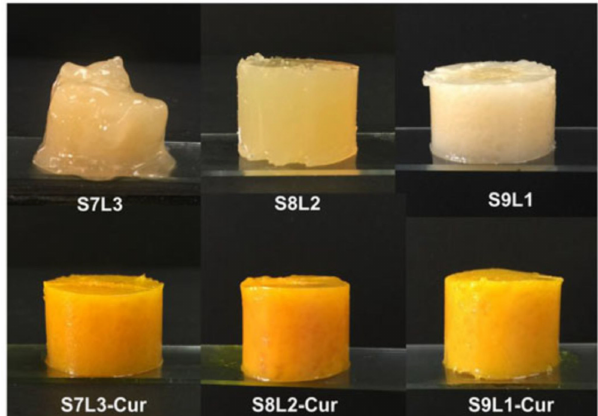
Figure 5. Oleogels developed with different ratios of β -sitosterol (S) and lecithin (L): 7:3, 8:2, and 9:1. The oleogels labelled with Cur are the ones loaded with curcumin. Reprinted from [86], with permission from